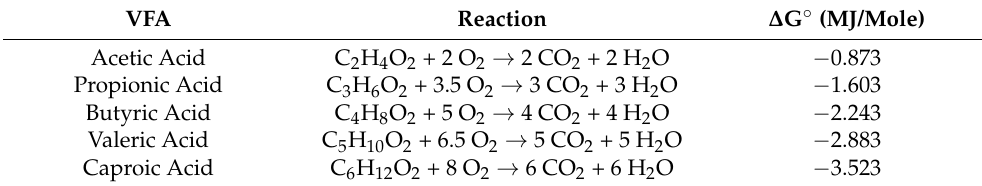
Table 2. Oxidation reactions of VFAs produced by dark fermentation and their ∆ G ◦ calculated from ◦ of pure ∆ G f